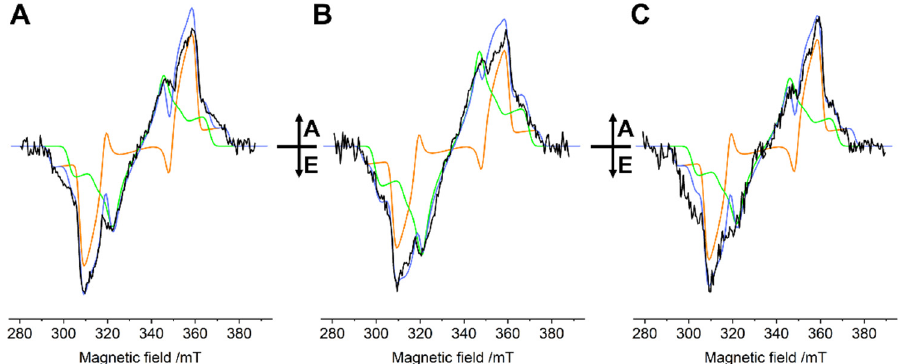
Figure 2. TR-EPR spectra (black) of ( A ) WT, ( B ) lut2 , and ( C ) lut2 npq2 LHCII variants taken 150 ns after the laser flash: All of the spectra were collected at 120 K and rescaled to the same concentration. Assignment according to Ref. [20]. Simulations of the TR-EPR spectra (light blue) obtained from the sum of the simulations of 3 Car (orange) and 3 Chl (green), optimised on the low-field half. The simulated 3 Car spectra were calculated using the following parameters: D = − 41.0 mT for WT and lut2 , − 41.4 mT for lut2 npq2 ; E = − 4.0 mT; (P x :P y :P z ) = (0.41:0.21:0.38; isotropic linewidth lw = 2.5 mT. The simulated 3 Chl a spectra were calculated using the following parameters: D = − 32 mT for WT, − 35 mT for lut2, and − 33 mT for lut2 npq2 ; E = − 3.0 mT; (P x :P y :P z ) = (0.36:0.44:0.20); isotropic linewidth lw = 3.5 mT. The simulations have a 3 Car/ 3 Chl ratio of 1.11 for WT, 0.67 for lut2 , and 1.08 for lut2 npq2 (note that the ratio is not indicative of the relative triplet amount, since polarisation strongly affects the TR-EPR signal intensity).